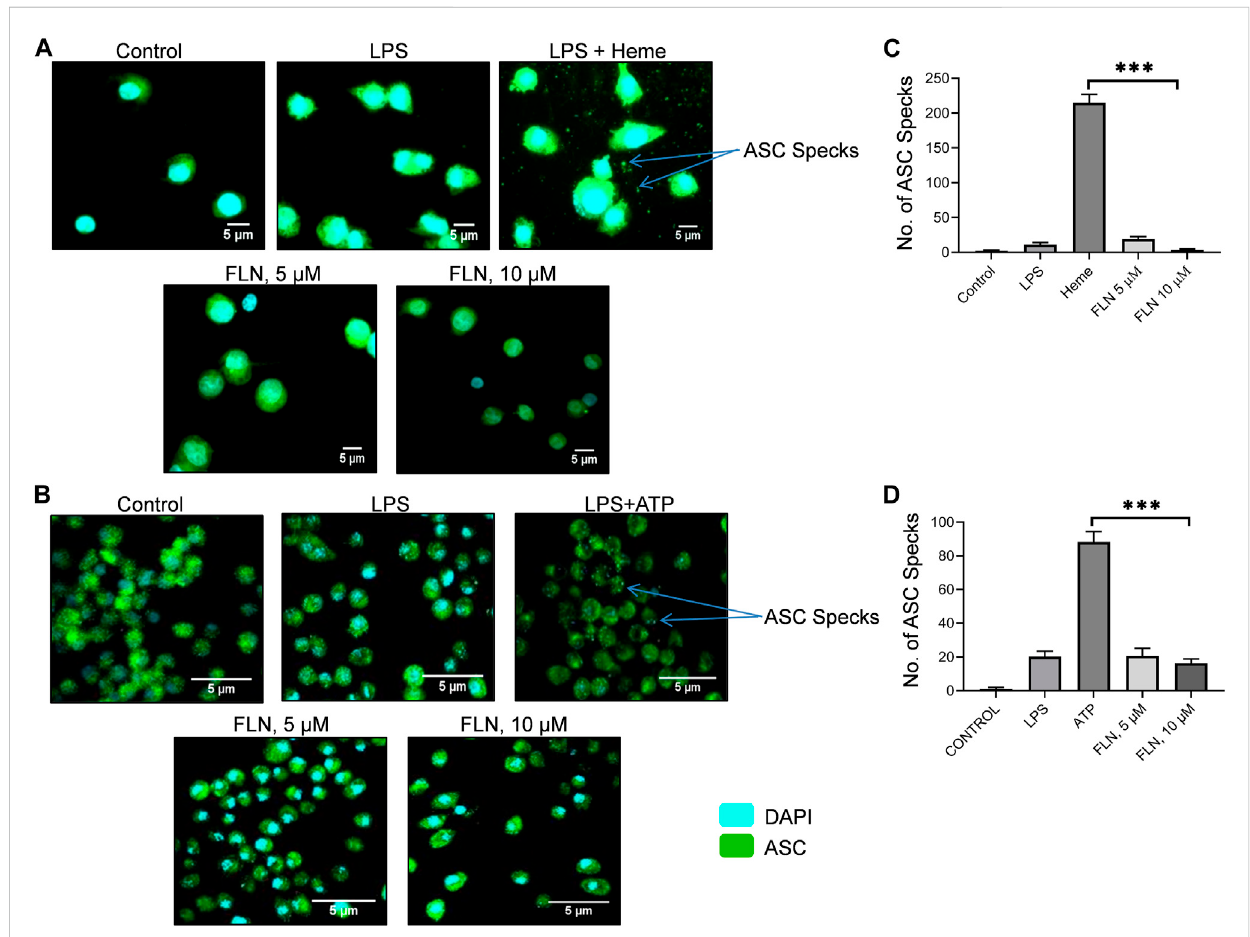
FIGURE 4 FLN inhibits ASC speck formation in THP-1 and J774A.1 cells. ASC specks were seen through CQ1 high throughput microscope. Scale bars were drawninImageJsoftware.ASColigomerizationorspecksarevisualizedasgreendots.RepresentativeimagesofASCspecksin (A) hemestimulatedTHP-1 cells (B) and in ATP stimulated J774A.1 cells. (C) number of specks quanti fi ed in THP-1 cells. (D) number of specks quanti fi ed in J774A.1 cells. Statistical signi fi canceofmeandatapresented(n=3)±SDwasseenbyapplyingone-wayANOVAanalysisand posthoc Bonferronitest.Pvalues*** p <